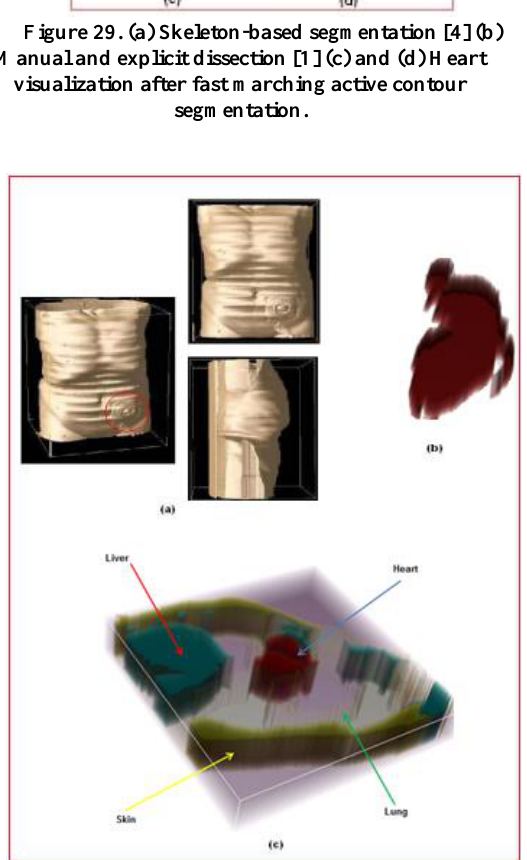
Figure 30. (a) This work’s skin visualization (b) This work’s heart visualization (c) This work’s abdomen